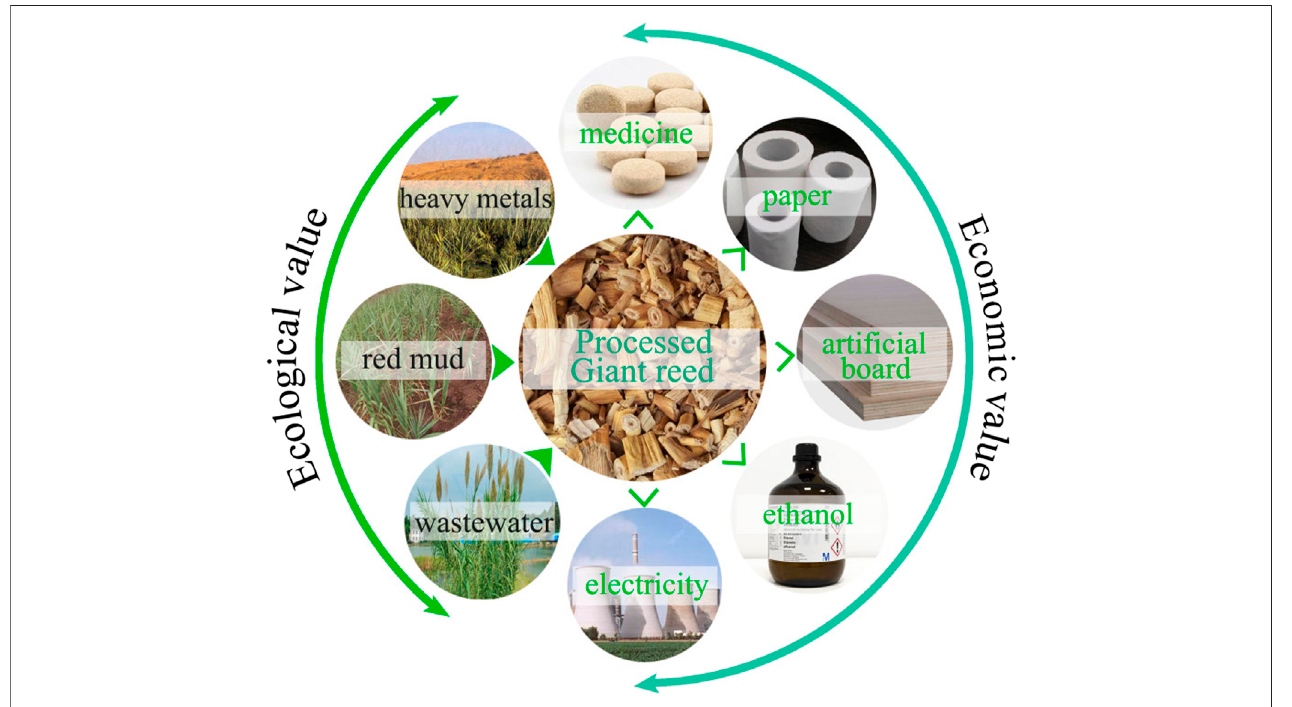
FIGURE 1 | Comprehensive application of giant